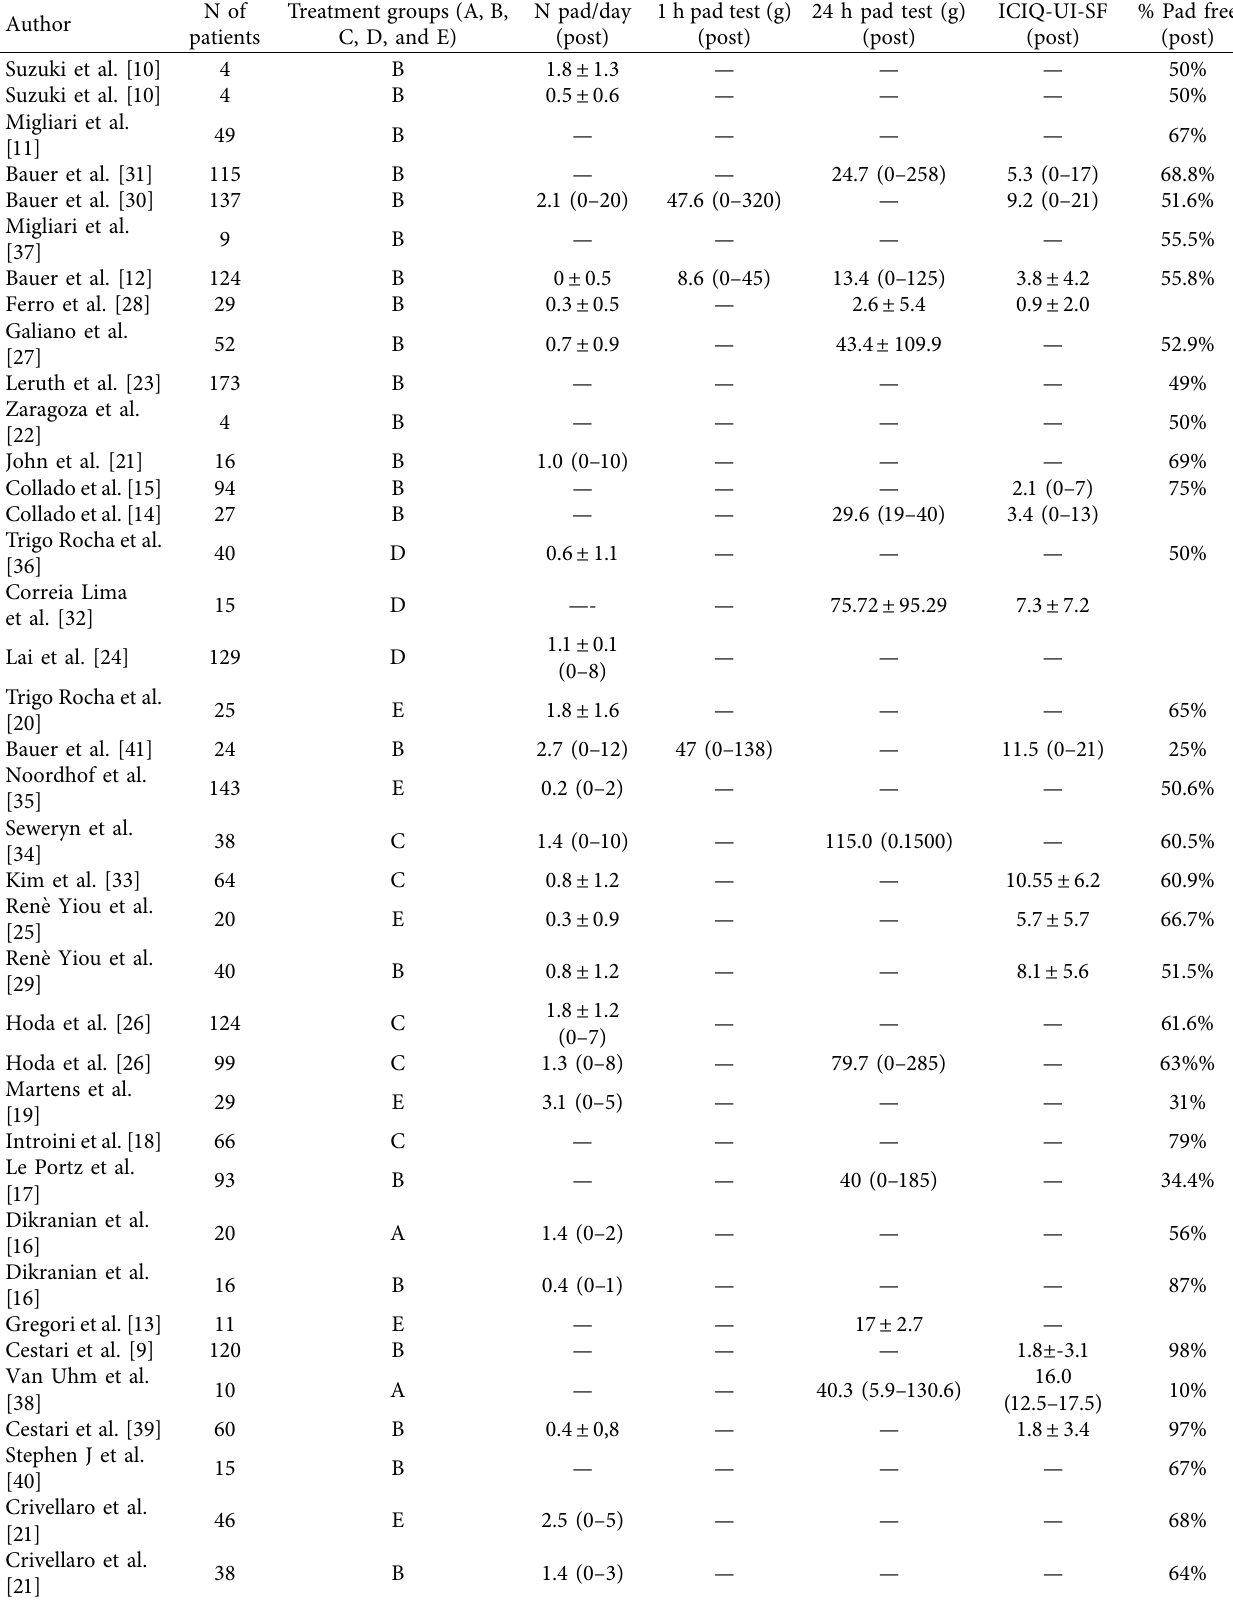
Table 4: 36 prospective clinical trials included in the analysis: posttreatment results. Number of cases; mean ± SD or median and